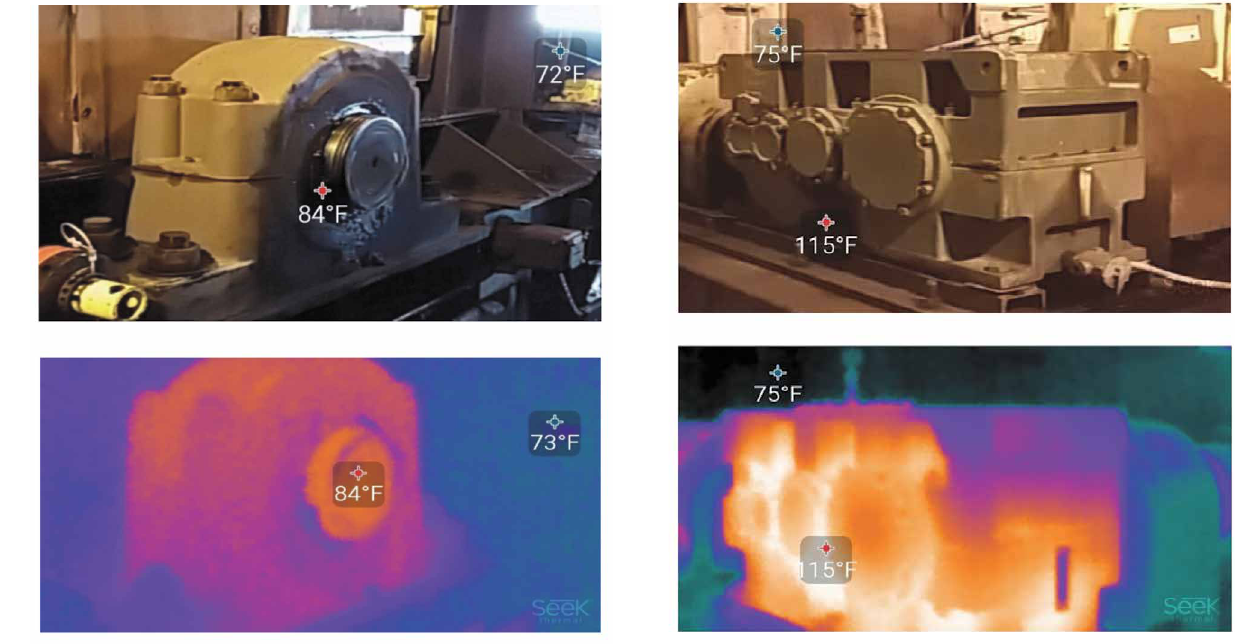
Figure 2. Thermal image of a pillow block bearing Figure 3. Thermal image of a